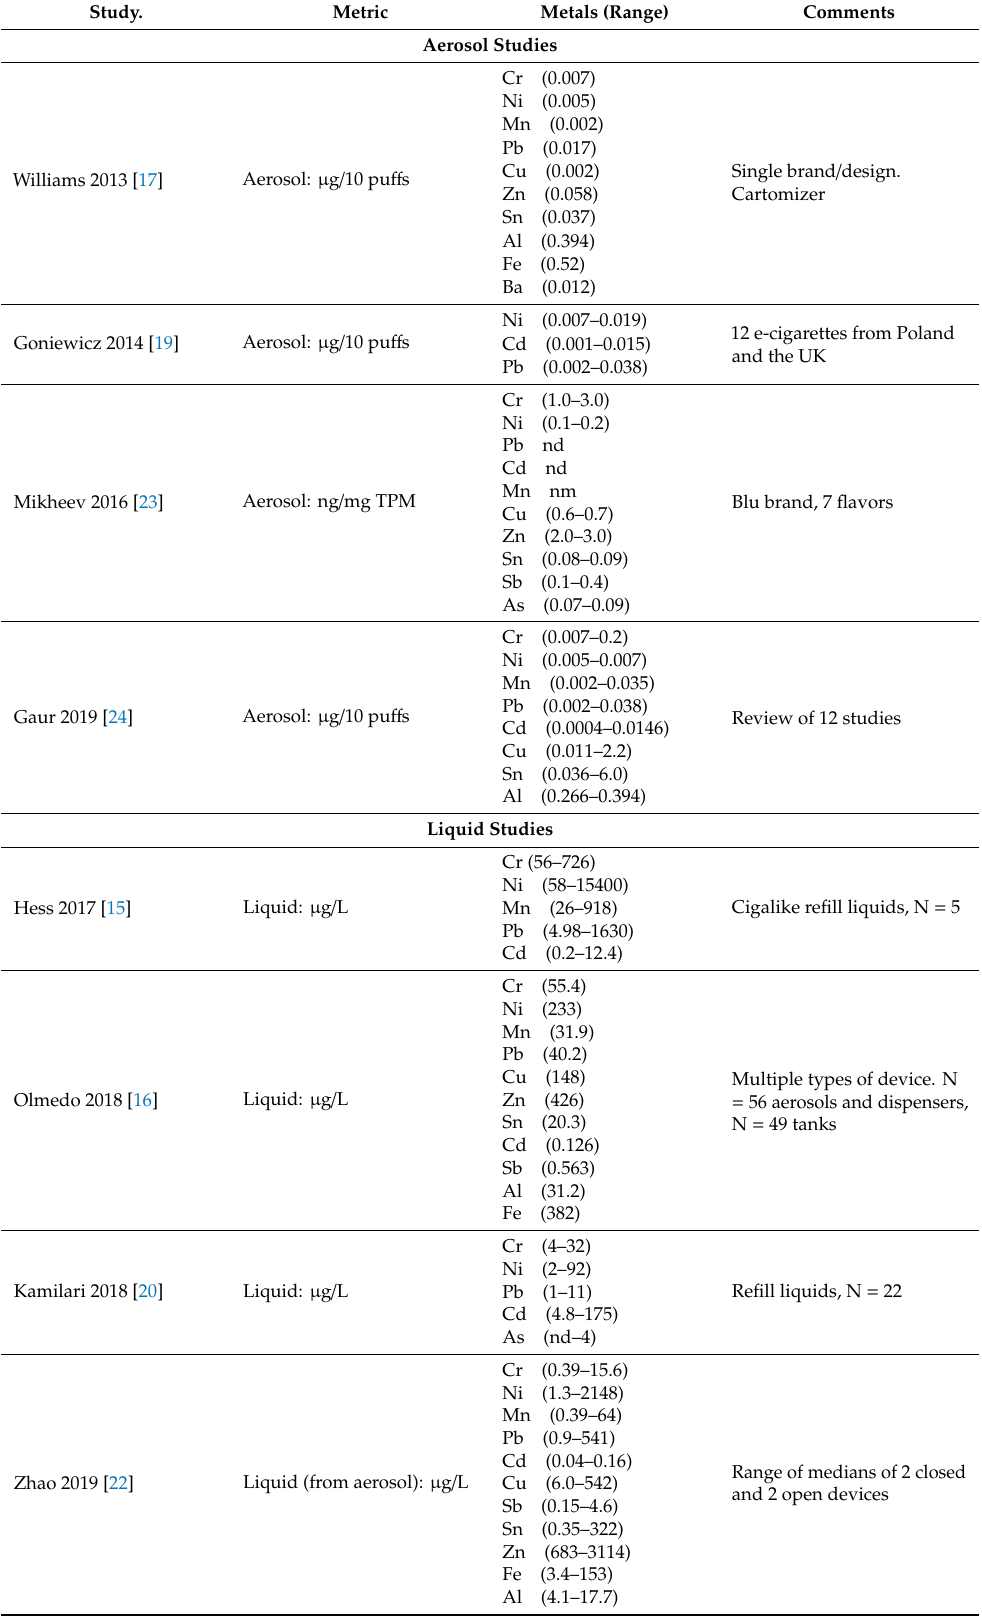
Table 1. List of studies and ranges of metal concentrations used in risk assessment in e-cigarettes.